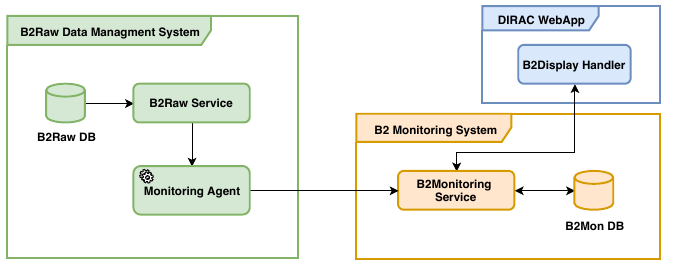
Figure 4. The Raw Data Management system sends information to the BelleDIRAC monitoring system, aiming for monitoring the registration and replication of raw data